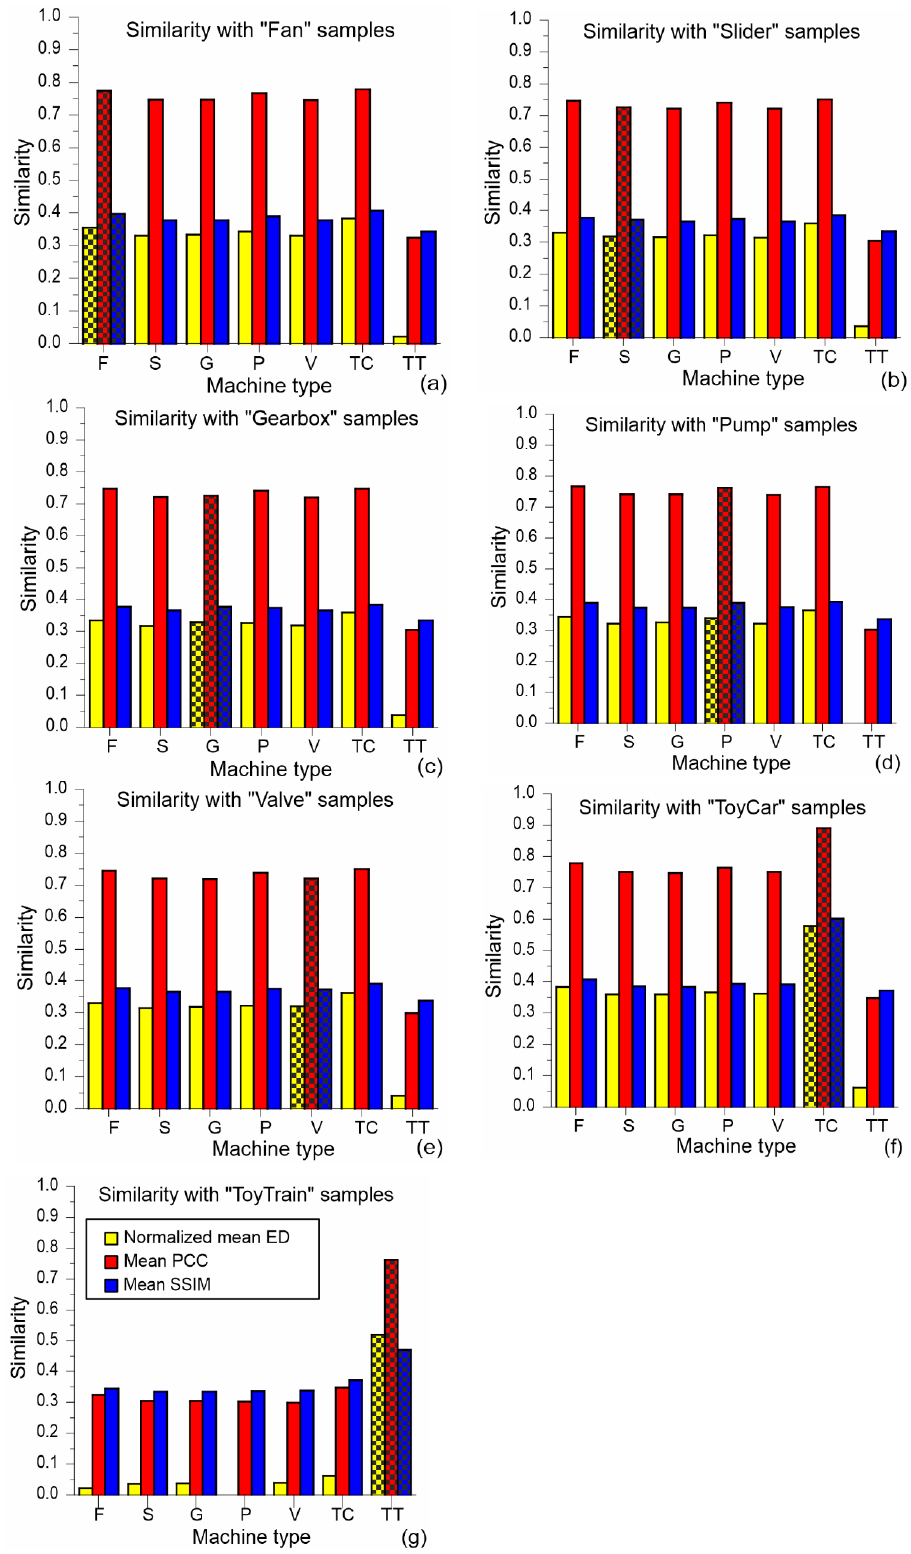
Figure 4. Mean values of intraclass (denoted by hatched bars) and interclass similarity (denoted by open bars) for the full dataset, where one sample in the similarity measures is always from a partic- ular class: ( a ) fan, ( b ) slider, ( c ) gearbox, ( d ) pump, ( e ) valve, ( f ) toy-car, and ( g ) toy-train (legend is the same for all plots).